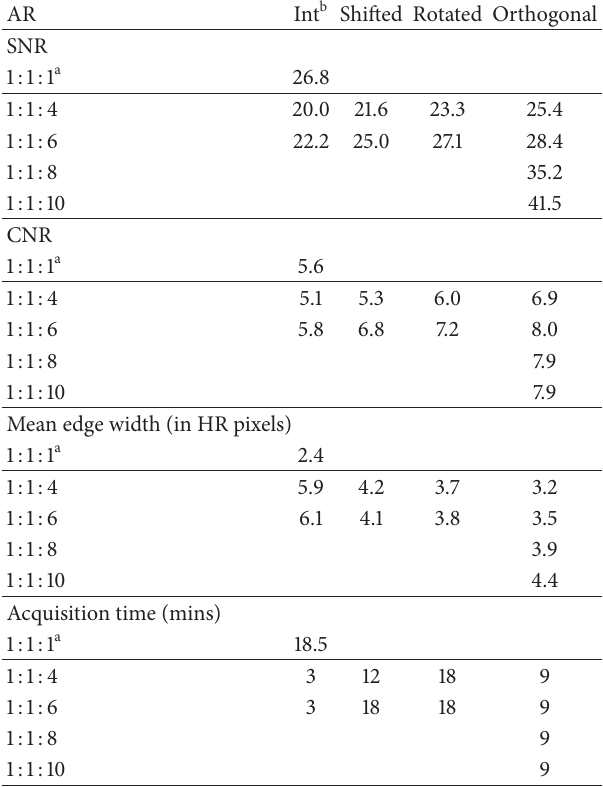
Table 1: Quantitative measures of image quality calculated from images of biological